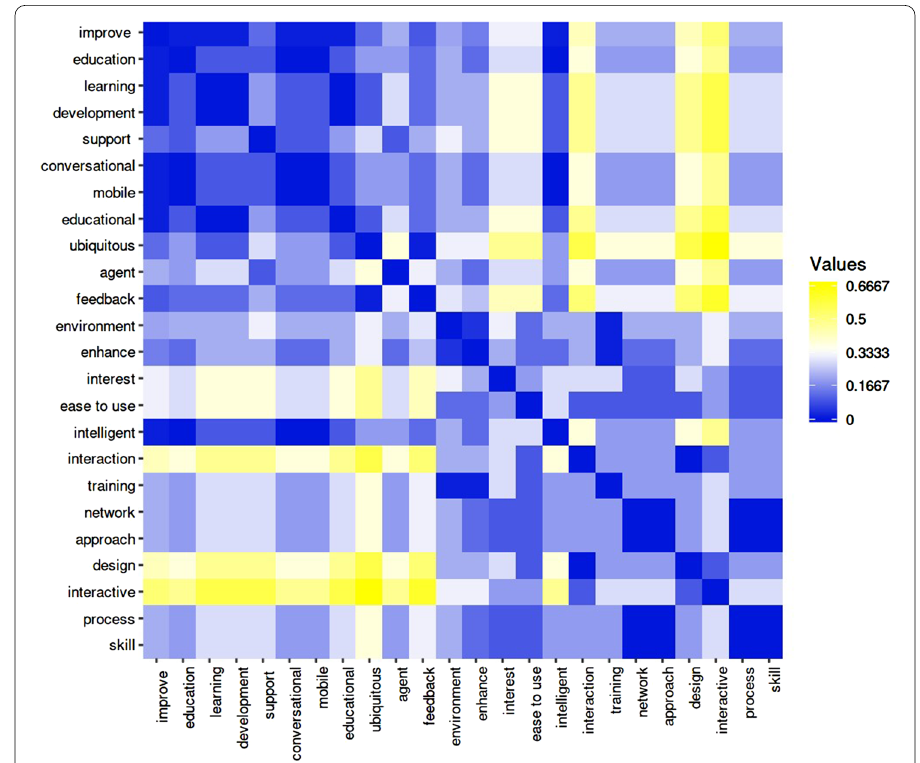
Fig. 5 Pairwise distance matrix of incidence of chatbots and the procesos of